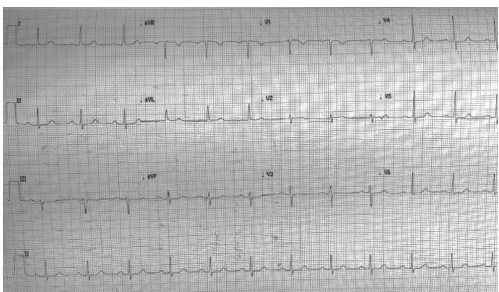
Figure 2: Postoperative ECG performed upon discharge from the